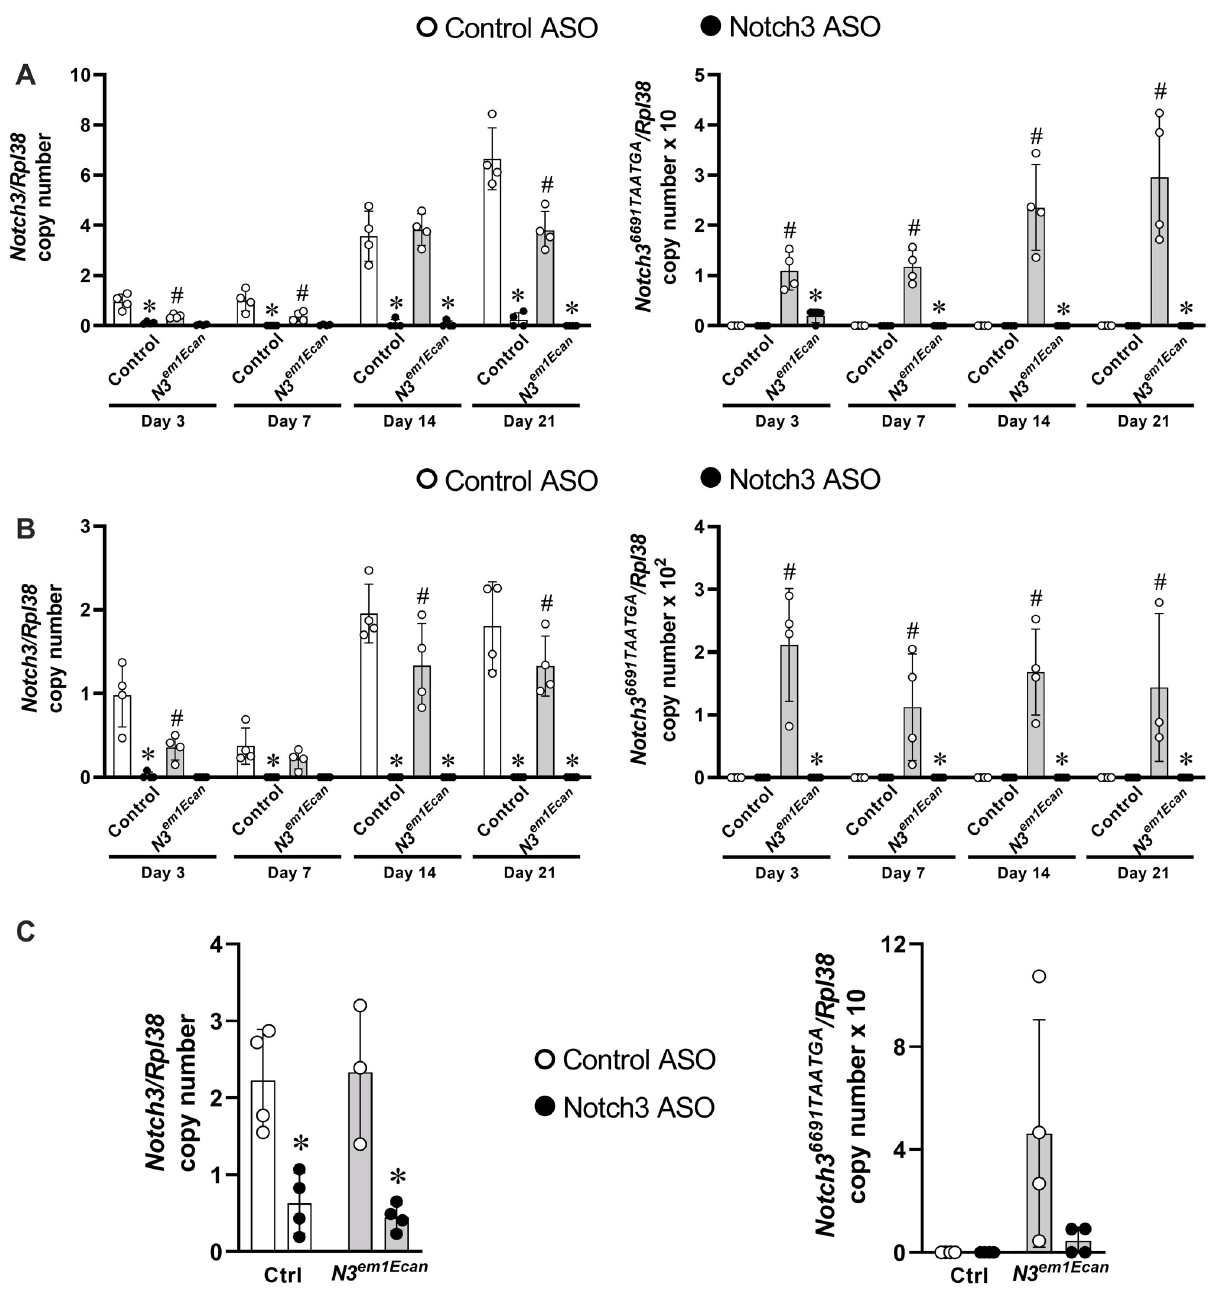
Fig 2. Effect of control or Notch3 ASOs on Notch3 and Notch3 6691TAATGA mutant mRNA in A. calvarial osteoblast-enriched cells, B. bone marrow stromal cells and C. osteocytes from control (white bars) and Notch3 em1Ecan mutant mice (gray bars). Osteoblasts or stromal cells were cultured for 3 weeks and osteocytes for 72h in the presence of Notch3 (closed circles) or control ASOs (open circles) at 20 μ M. In A, B and C, transcript levels are expressed as copy number corrected for Rpl38 . Individual values are shown, and bars and ranges represent means ± SD; n = 4 technical replicates in A and B and biological replicates in C. � Significantly different between Notch3 ASO and control ASO, p < 0.05. #Significantly different between Notch3 em1Ecan and control cells, p <